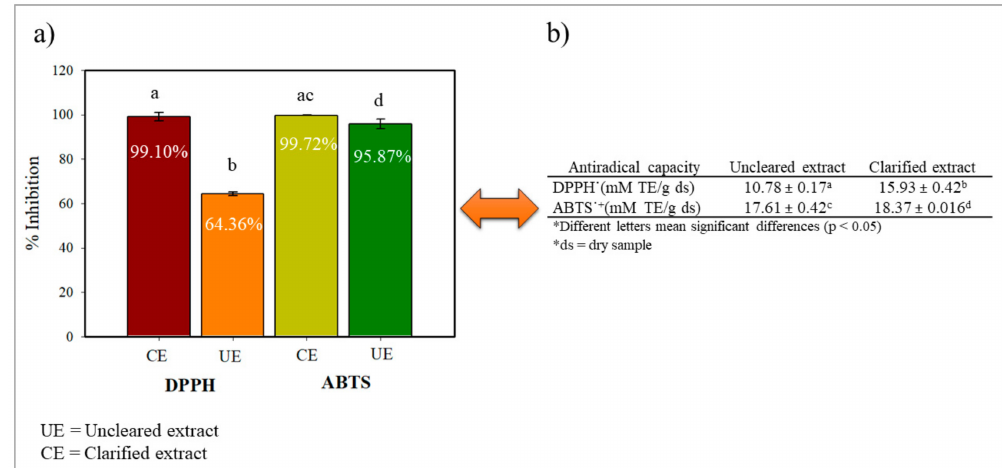
Figure 2. Antiradical capacity ABTS · + and DPPH · ( a ) presented in percent inhibition and ( b ) in Trolox equivalents of the UE and CE of pitaya ( Stenocereus thurberi ).